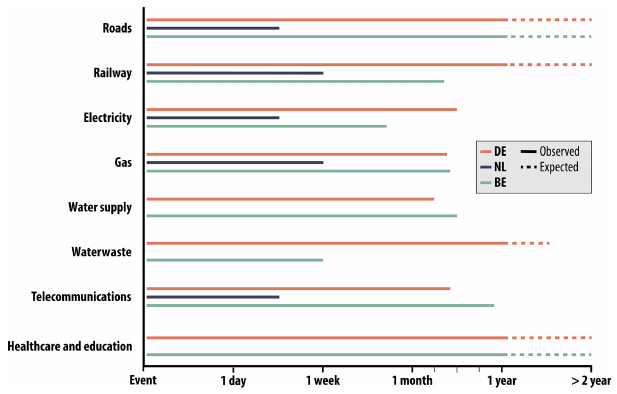
Figure 2. Overview of observed and expected reconstruction dura- tion of each infrastructure sector considered in this study. It should be noted that this figure presents reconstruction efforts of the sys- tem. No line indicates that no impacts are observed. Solid waste is not included in the figure, as no impacts were recorded within each